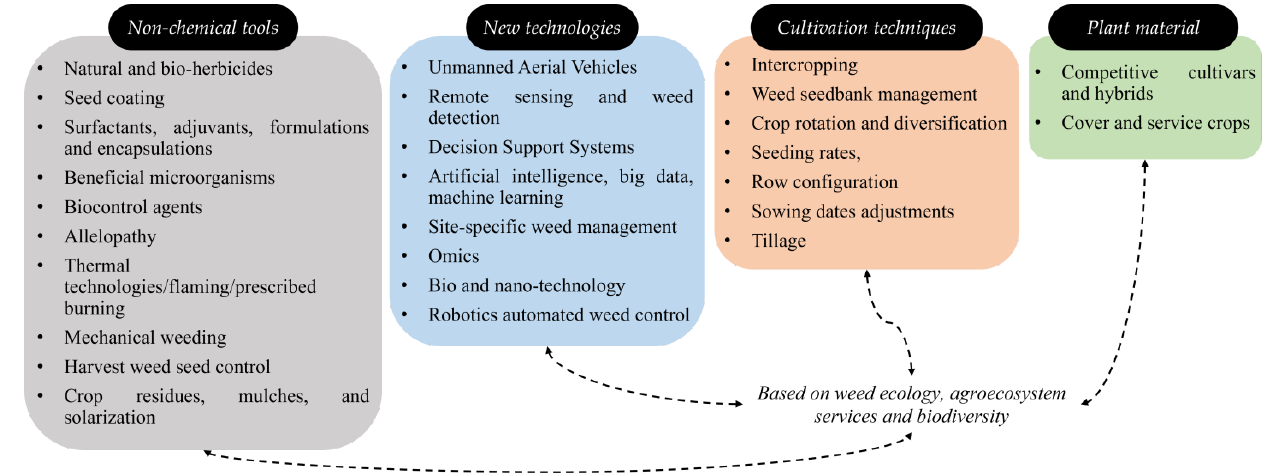
Figure 2. A holistic framework for the optimization of weed management in the era of the EU Green Deal .